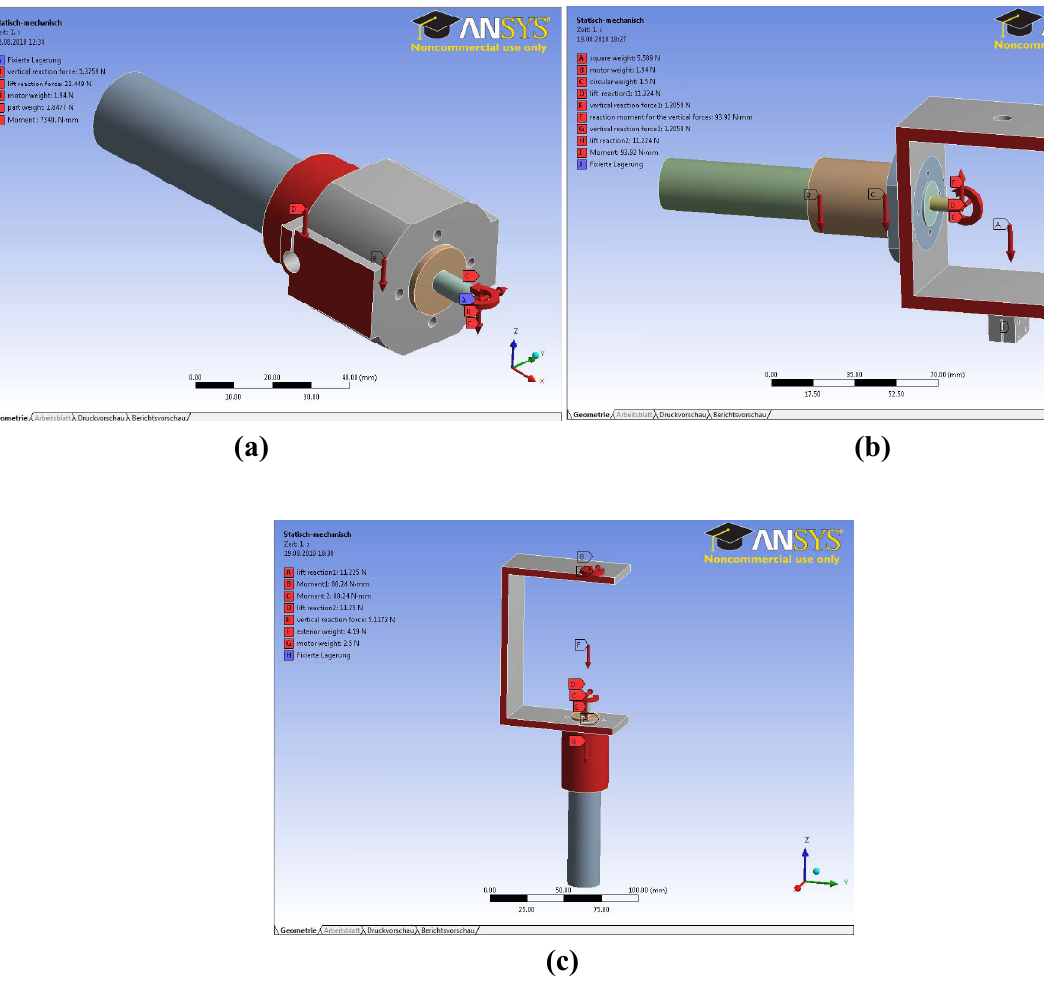
Figure 7. Images of the static mechanical analysis of the hydrofoil propulsion